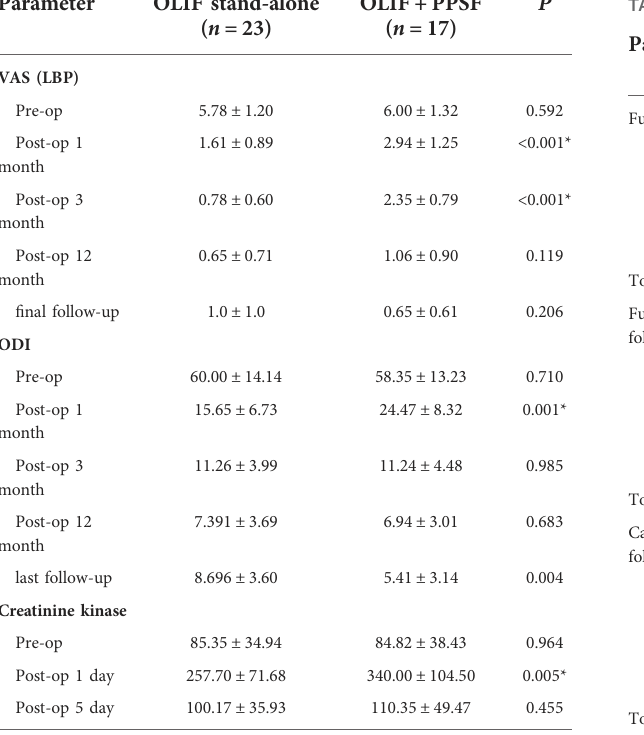
TABLE 4 Radiological